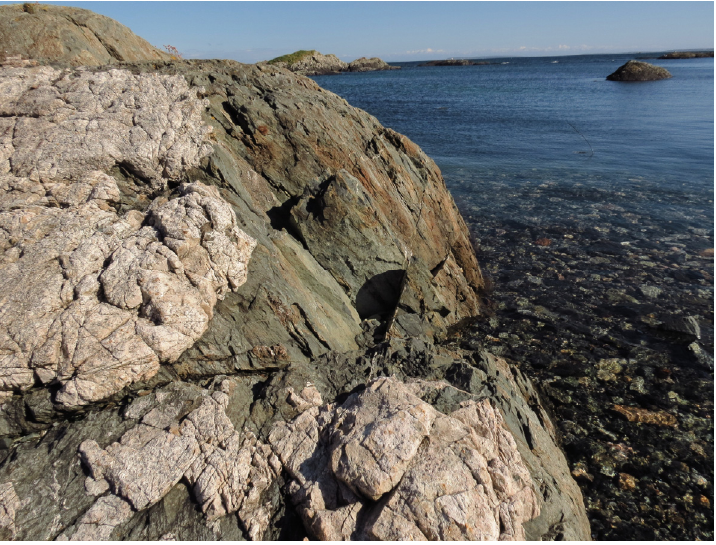
Figure 4. Gorumna Island, County Galway: Ordovician volcanics (green) cross cut by granite.